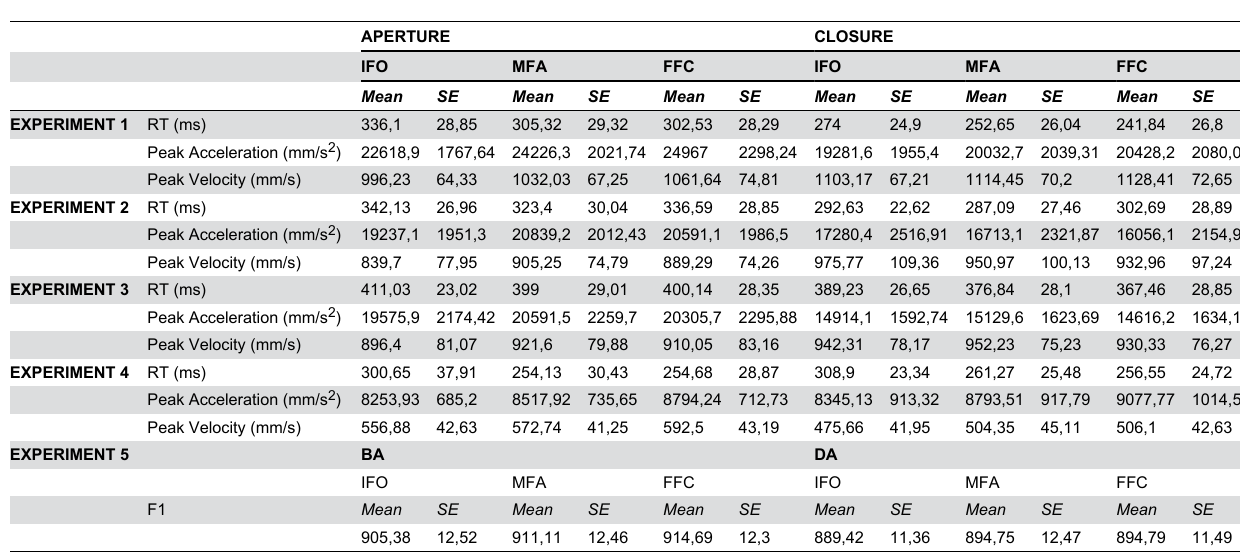
Table 1. Means and SE of kinematic and vocal parameters collected in experiments 1- 5.